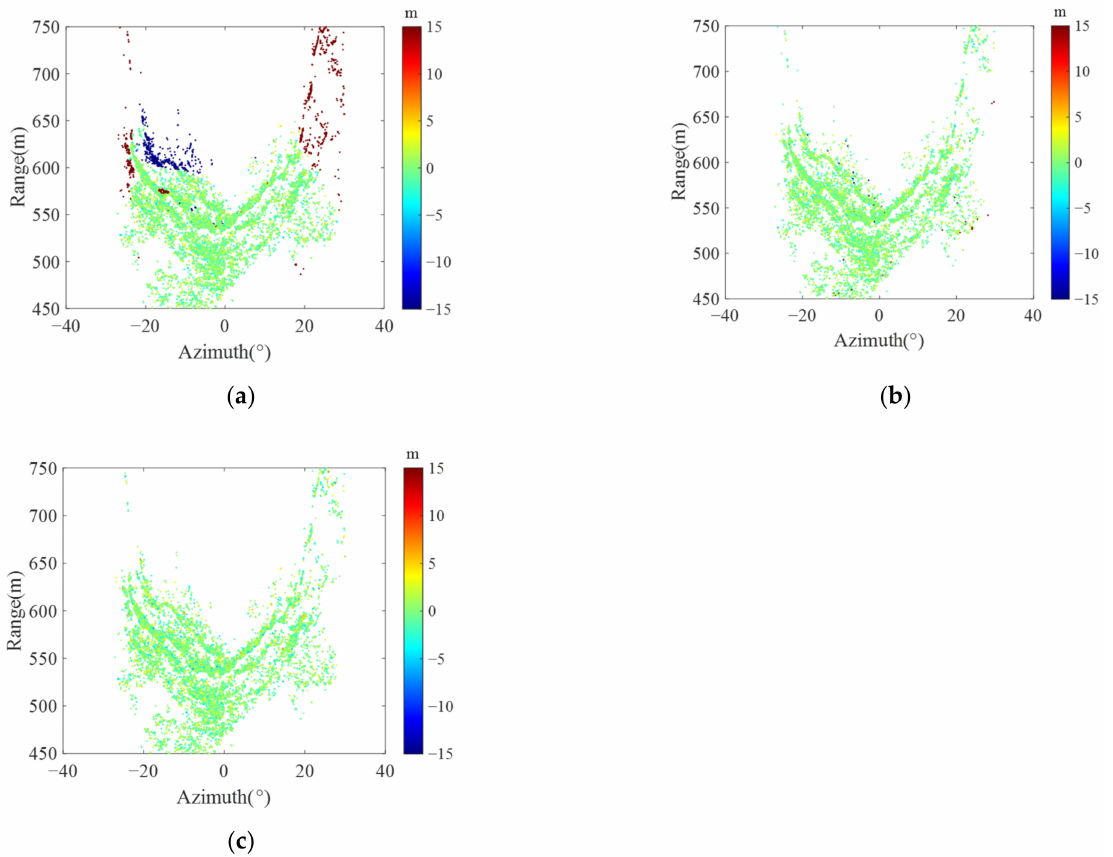
Figure 8. The Elevation error distribution of different algorithms. ( a ) MCF. ( b ) CA-based MB PU. ( c ) CA-based MB PU +